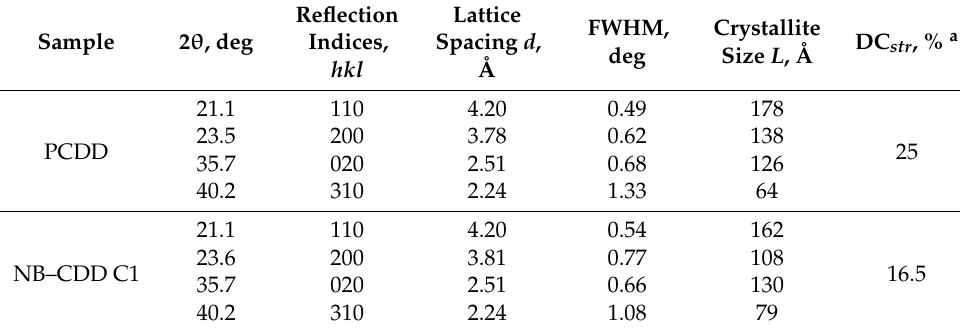
Table 2. Characteristics of the main XRD